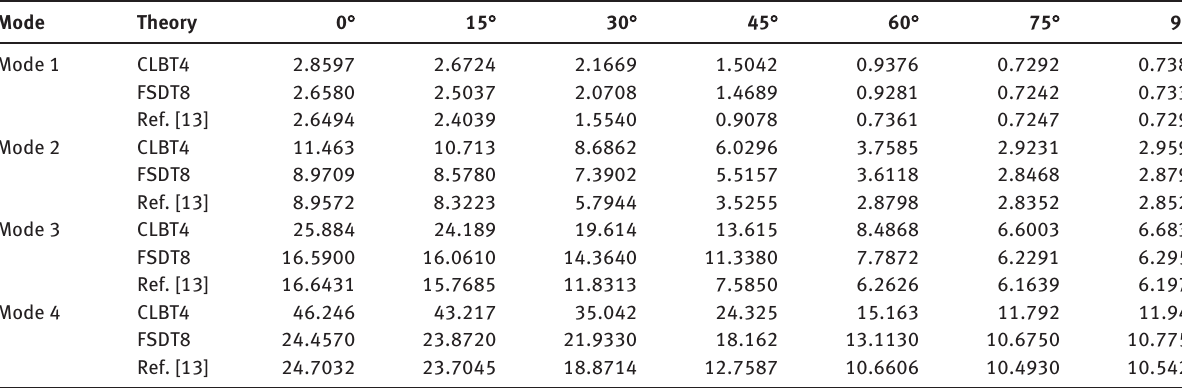
Table 2 The first four non-dimensional natural frequencies of a simply supported anti-symmetric angle-ply ( θ ° /- θ ° ) composite beam with material I.